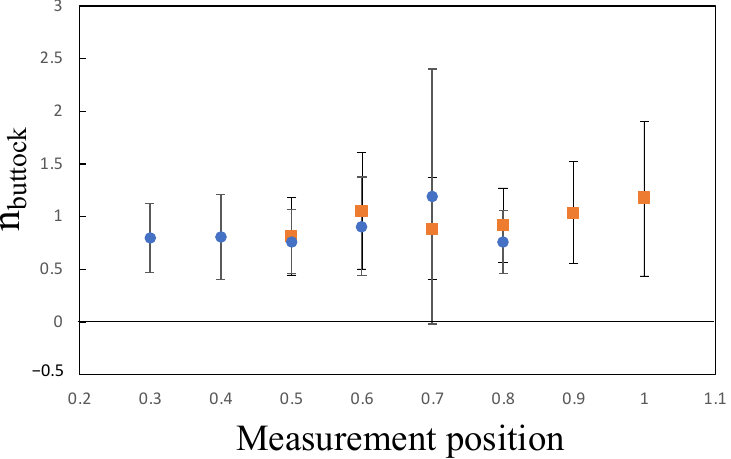
Figure 6. The average value and standard deviation of the exponent of the power function obtained from measured data.